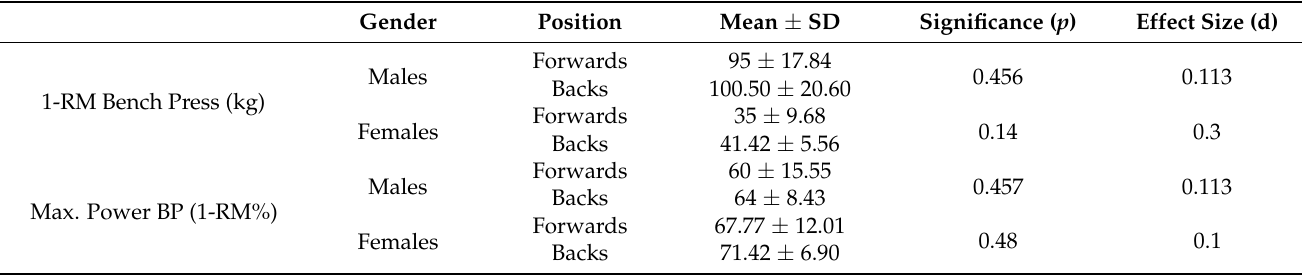
Table 3. Bench Press comparisons between positions by